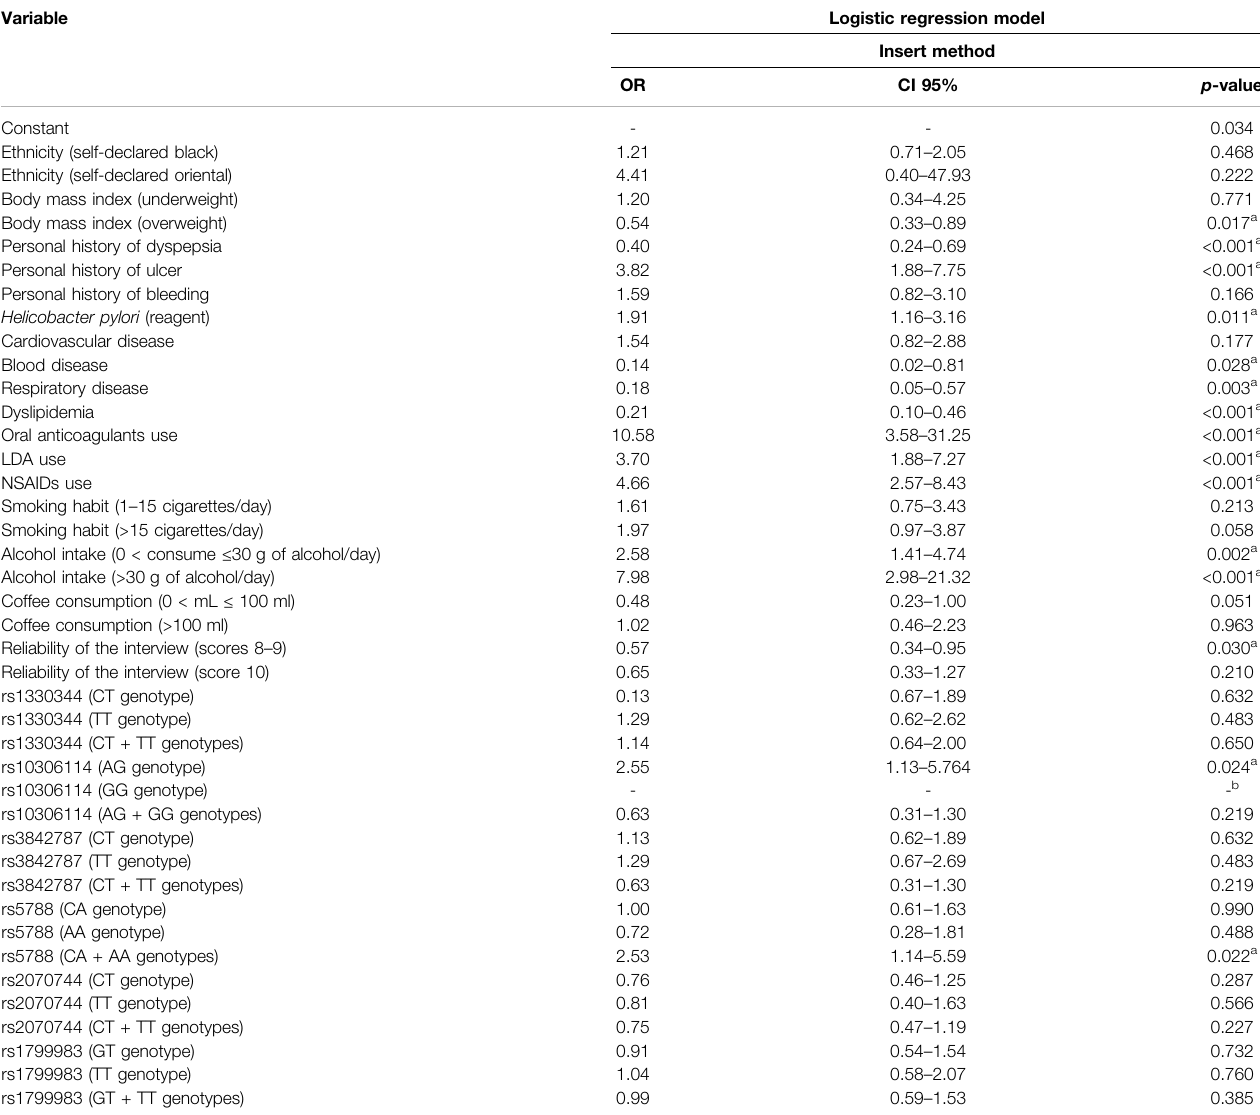
TABLE 3 | Risk of upper gastrointestinal bleeding secondary to complicated peptic disease after the logistic regression model.